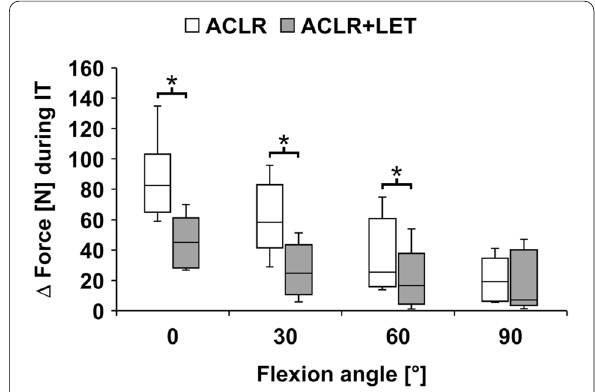
Fig. 4 Graft forces in the anterior cruciate ligament reconstruction (ACLR) during the application of internal tibial torque (IT) for the isolated ACLR and the ACLR with addition of a lateral extra-articular tenodesis (ACLR LET). The forces indicated in the graph are relative + to the unloaded state (Δ force). Significant differences between the two procedures are marked with an asterisk (*)